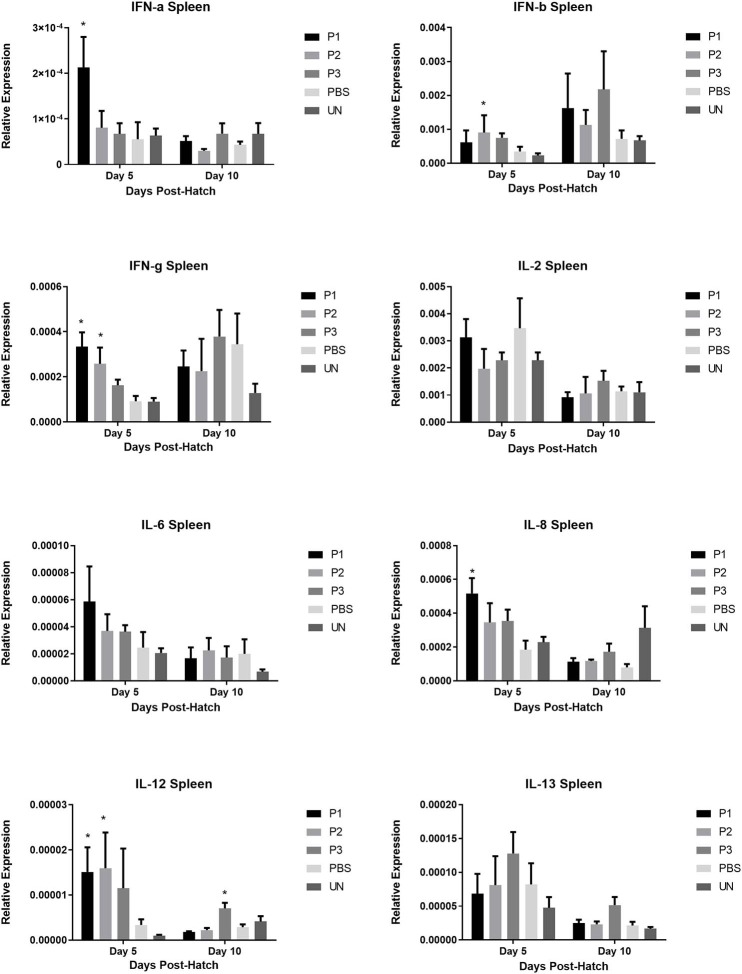
Relative gene expression of IFN-α, IFN-β, IFN-γ, IL-2, IL-6, IL-8, IL-12, and IL-13 in the spleen of chickens at days 5 and 10 post-hatch. Samples collected from 6 birds per treatment. Treatment groups were as follows: P1, P2, and P3 received 1 × 105, 1 × 106, 1 × 107 CFU/egg of a selected mixture of Lactobacillus bacteria (Lactobacillus salivarius, Lactobacillus reuteri, Lactobacillus crispatus, and Lactobacillus johnsonii), respectively (PBS, phosphate-buffered saline group; and UN, non-injected eggs). The reference gene (Beta-actin) was used for relative gene expression. Statistical significance among treatment groups was calculated using one-way ANOVA followed by Tukey's comparison test. Error bars represent standard errors of the mean. Results were considered statistically significant from the control group if P < 0.05. *Bars with asterisks differ significantly from control (PBS) group.